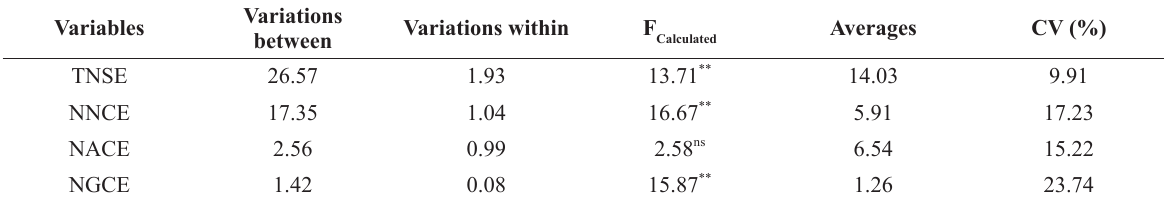
Analysis of variance for total number of somatic embryos (TNSE), number of normal cotyledonary embryos (NNCE), number of abnormal cotyledonary embryos (NACE) and number of germinated cotyledonary embryos (NGCE) of